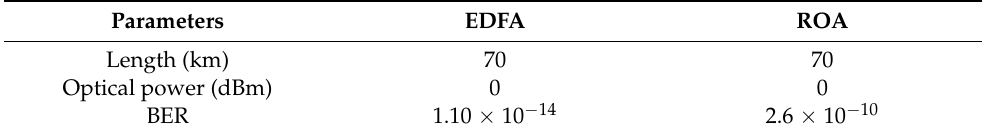
Table 6. Parameters and results of 32-channel WDM [24].